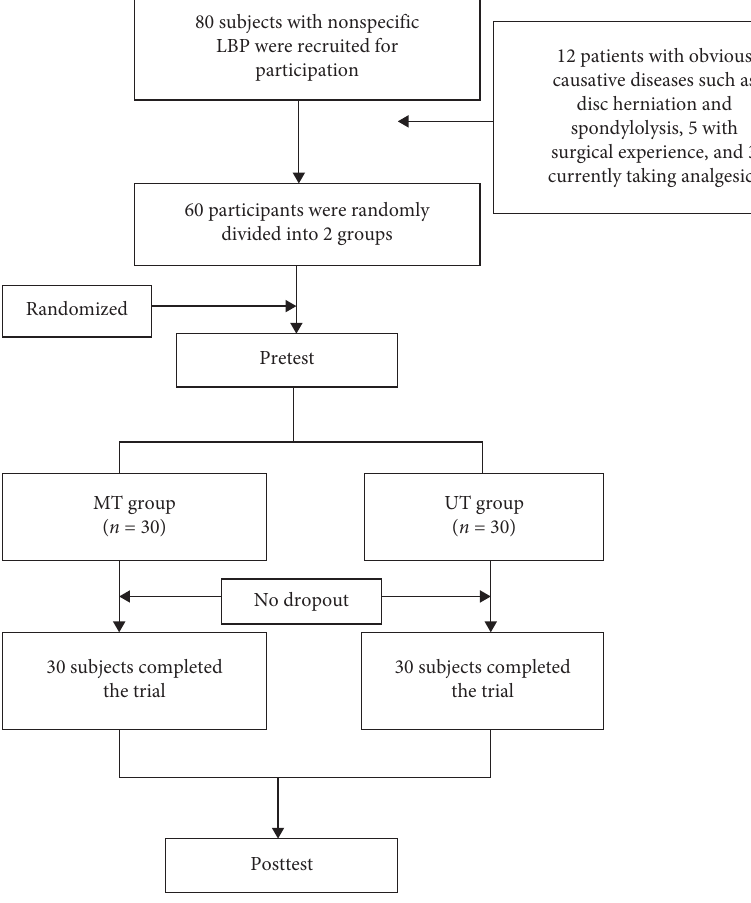
Figure 1: Flow diagram of participants through the Table 1: Common and clinical characteristics of the subjects ( N � 60).